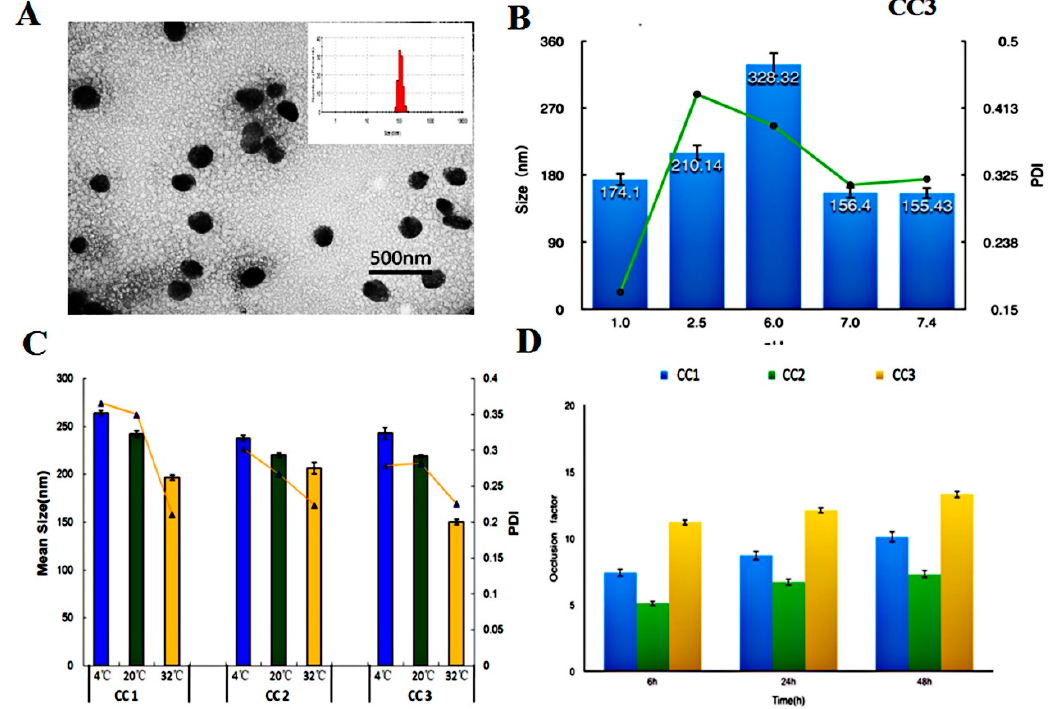
Figure 3. ( A ): TEM of self-aggregates based on CC3 conjugate; ( B , C ): The changes of size and PDI of Figure 3. ( A ) ： TEM of self-aggregates based on CC3 conjugate; ( B ), ( C ): The changes of size and PDI CC-NPs (nanoparticles) at di ff erent pH ( B ) and temperature ( C ); ( D ): Occlusion factors of of CC-NPs (nanoparticles) at different pH ( B ) and temperature ( C ); ( D ): Occlusion factors of CC-NPs.